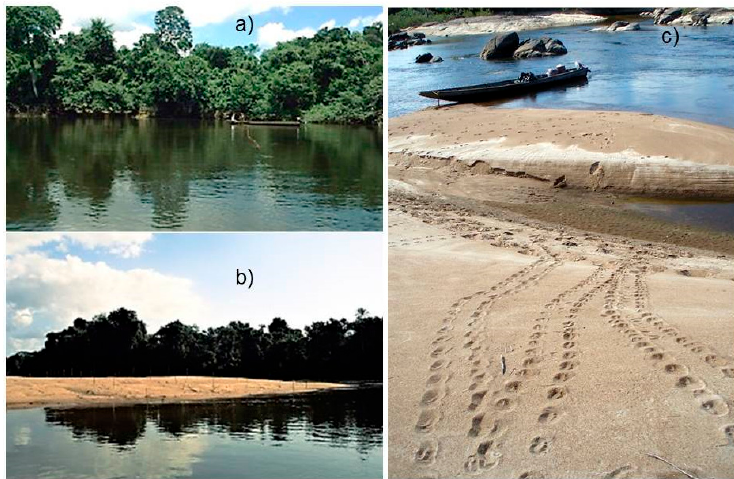
Figure 2. Nichare River, showing high flow ( a ), nesting grounds exposed during low flow ( b ), and tracks left on the beach by female Podocnemis unifilis during their nesting forays ( c ).